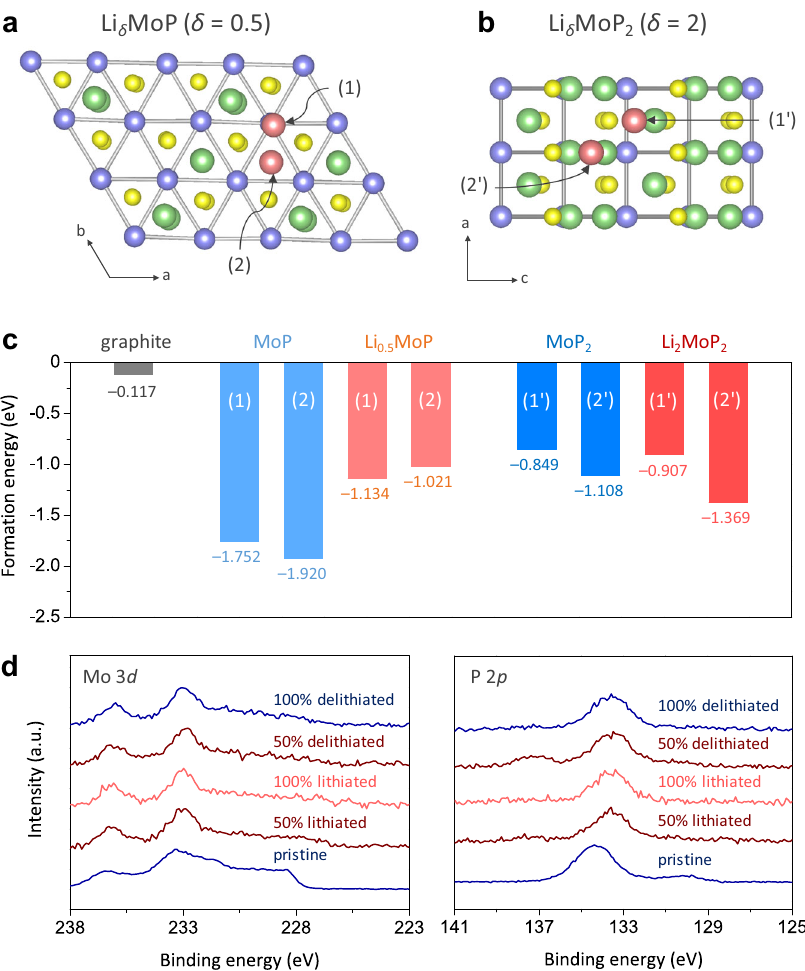
Fig. 3 Li + adsorption on MoP x . a – c Atomic arrangements ( a , b ) and formation energies ( c ) for Li + adsorption on Li δ MoP ( δ = 0.5) and Li δ MoP 2 ( δ = 2) determined by the DFT calculations. d Ex situ XPS Mo 3 d and P 2 p spectra of MoP x recorded at different lithiation states. Lithiation and delithiation experiments were conducted by applying a constant current density of 100 mA g − 1 in a voltage range of 0.01 – 1.5 V vs. Li/Li +